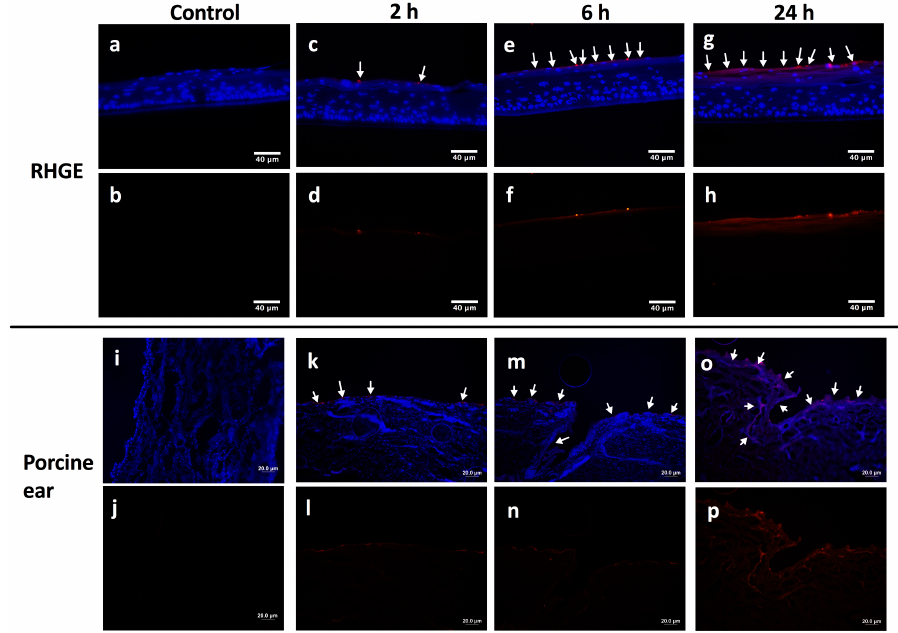
Figure 4. The merged fluorescent images and red fluorescent channels of RITC ‐ NPs in the reconstructed human gingival epithelia (RHGE) at 0 ( a , b ), 2 ( c , d ), 6 ( e , f ) and 24 h ( g , h ) as well as the porcine ear skin at 0 ( i , j ), 2 ( k , l ), 6 ( m , n ) and 24 h ( o , p ). The blue and red fluorescence reflects the cell nuclei and RITC ‐ NPs, respectively. Scale bars: 40 μ m in RHGE images and 20 μ m in porcine ear skin images.